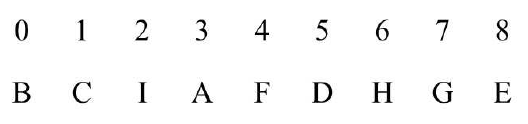
Figure 2. Chromosome of a multigene family.